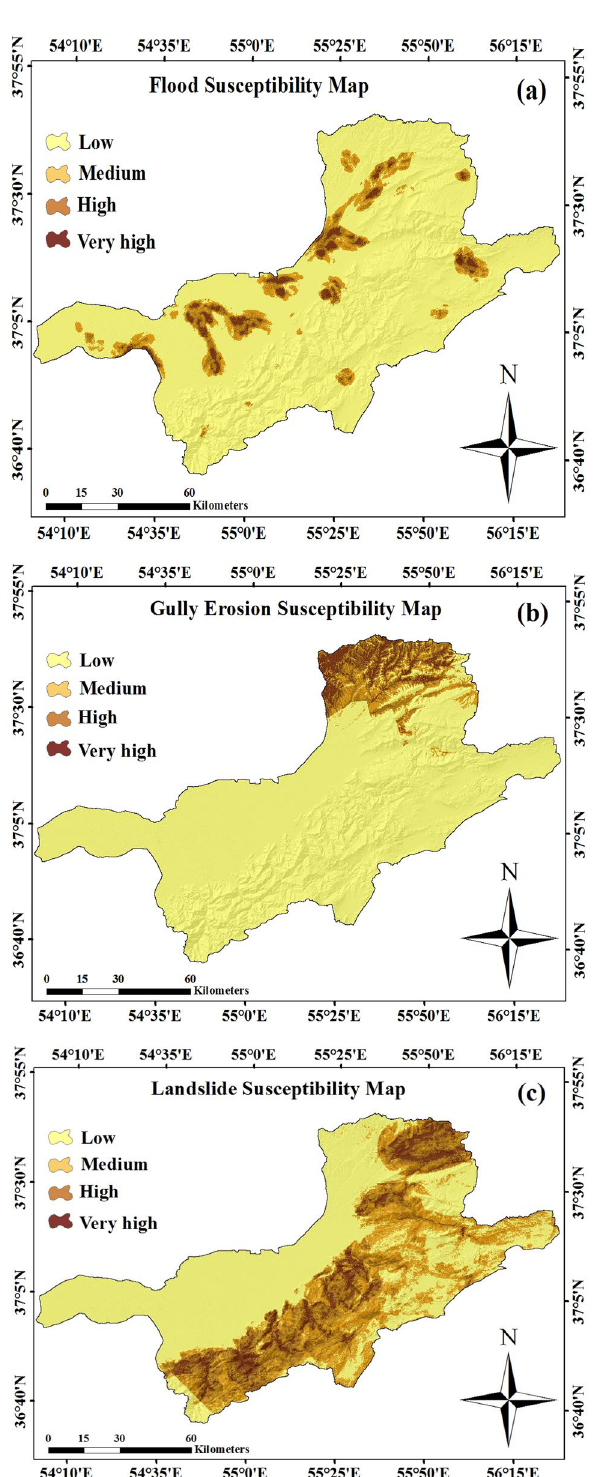
Figure 4. Susceptibility mapping for ( a ) floods, ( b ) gully erosion, ( c ) and landslides using MaxEnt model in the study